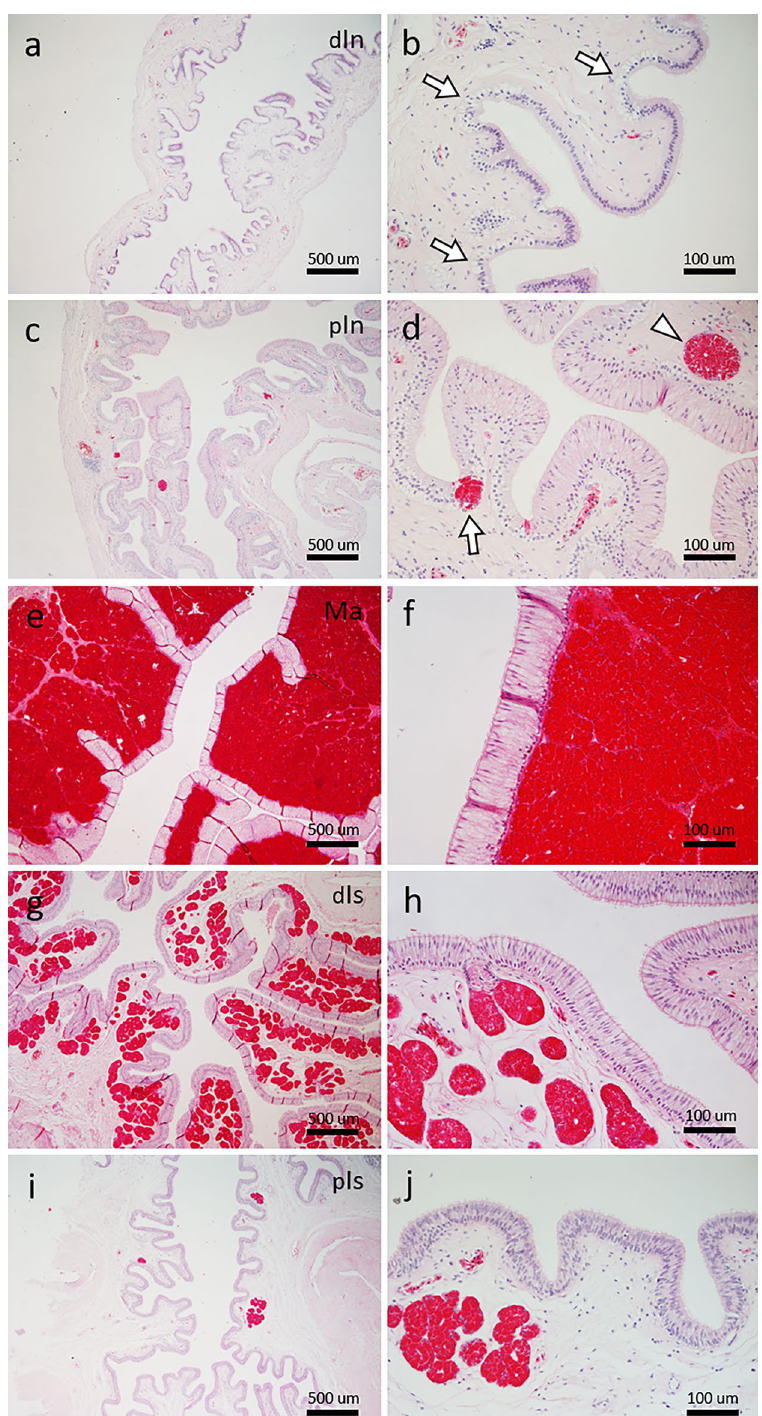
Figure 2. Histological features of oviduct from infundibulum to isthmus in green turtle (ID-035). ( a,b ) Distal portion of infundibulum (dIn). Arrows indicate interepithelial multicellular glands without eosinophilic granules. ( c,d ) Proximal portion of infundibulum (pIn). Arrow and arrowhead indicate eosinophilic interepithelial glands and eosinophilic acini of glands in lamina propria, respectively. ( e,f ) Magnum (Ma). Lamina propria contains eosinophilic glands. ( g,h ) Distal portion of isthmus (dIs). Eosinophilic glands are less abundant than those in magnum. ( i,j ) Proximal portion of isthmus (pIs) contains some eosinophilic glands. Bars 500 ( a,c,e,g,i ) and 100 ( b,d,f,h,j )